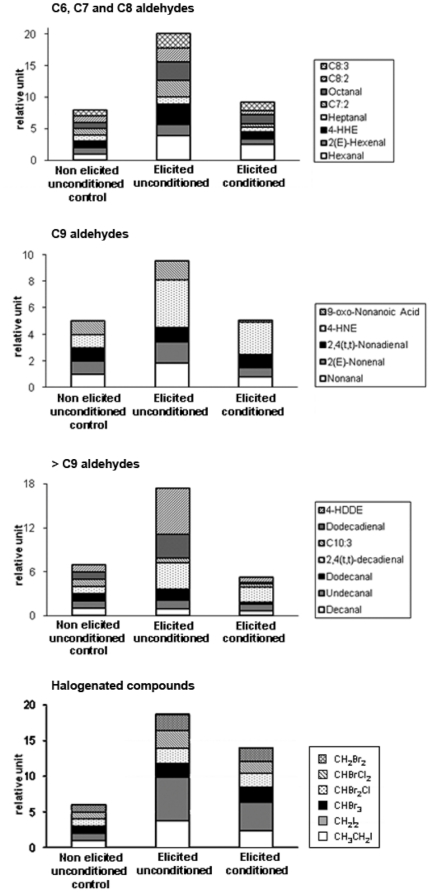
Release of VOCs by conditioned and unconditioned L. digitata sporophytes after elicitation with GGs.VOCs were quantified in the medium surrounding L. digitata 1 h after challenge or not with GGs. For each compound, the non elicited unconditioned control level was set to a relative unit of 1 to express the fold-variation in the other conditions (absolute concentration values are provided in Tables S1 and S2). 4-HHE, 4-hydroxy-(E)-2-hexenal; C7:2, (E,E)-2,4-heptadienal; C8:2, 2,4-octadienal; C8:3, 2.4.7-octatrienal; 4-HNE, 4-hydroxy-(E)-2-nonenal; C10:3, 2.4.7-decatrienal; 4-HDDE, 4-hydroxydodecadienal; CH3CH2I, iodoethane; CH2I2, diiodomethane; CHBr3, bromoform; CHBr2Cl, dibromochloromethane; CHBrCl2, bromodichloromethane; CH2Br2, dibromomethane. Values are means of three independent replicates.